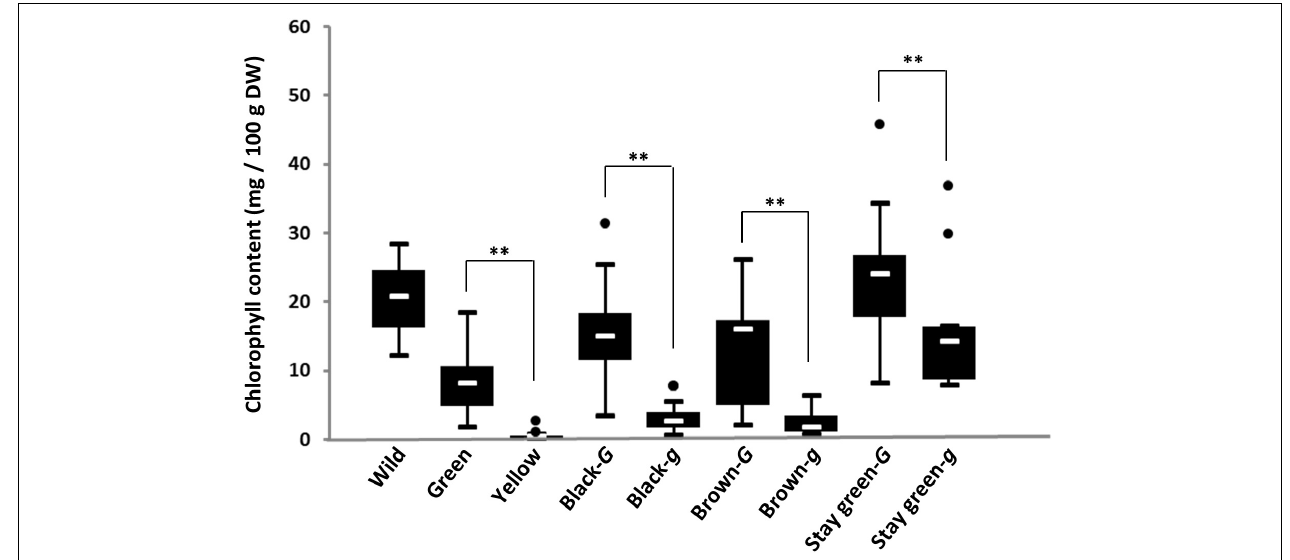
FIGURE 3 | Box-plots of the chlorophyll content in the seed coats of soybean germplasm. Eight soybean groups were evaluated: wild soybean (Wild), green seed coat (Green), yellow seed coat (Yellow), black seed coat with the G allele (Black- G ), black seed coat with the g allele (Black- g ), brown seed coat with the G allele (Brown- G ), brown seed coat with the g allele (Brown- g ), green cotyledon with the G allele (stay-green- G ), and green cotyledon with the g allele (stay-green- g ). The seed coat color and genotypes for the G locus of soybean germplasm used in this study are listed in Supplementary Table 2 . White lines in black boxes indicate mean values. ∗∗ denotes a significant difference at the 1%